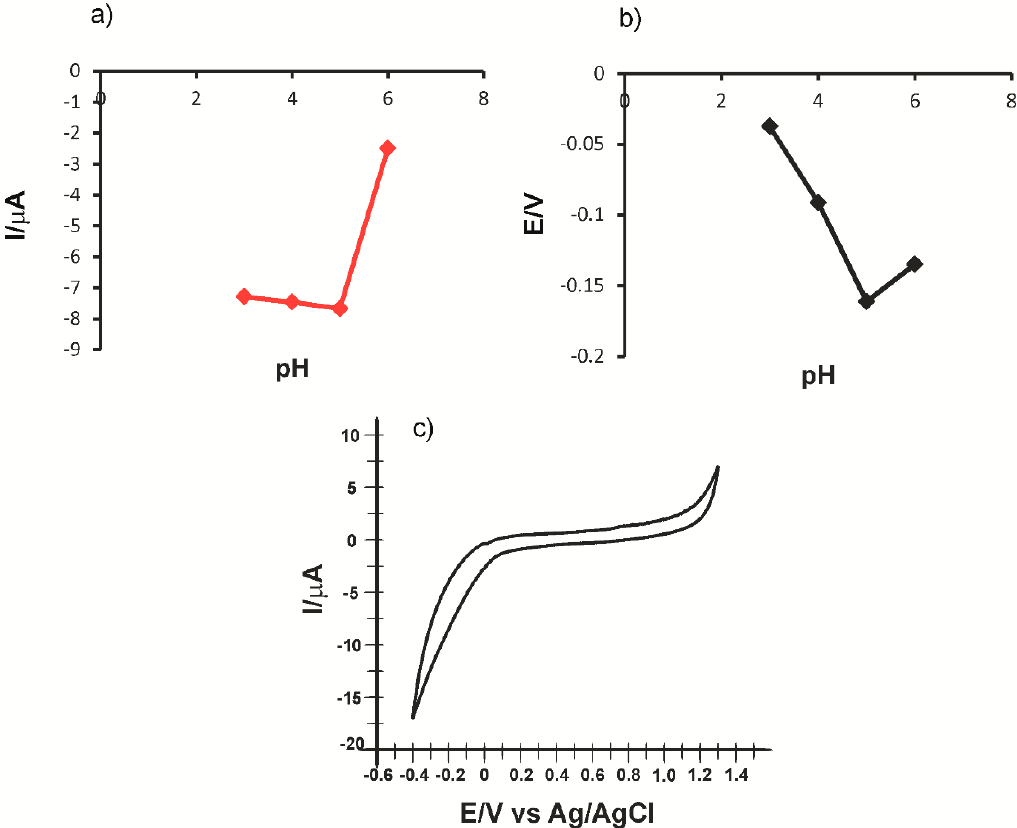
Figure 2. pH influence on the cathodic peak current intensity ( a ) and the cathodic peak potential ( b ) obtained by immersing CNF-CoPc-Lac/SPE in PBS and CV of CNF-CoPc-Lac/SPE immersed in PBS 0.1 M pH = 5.0 ( c ) CV parameters: scan rate 0.1 V/s and potential range from − 0.4 to +1.3 V.